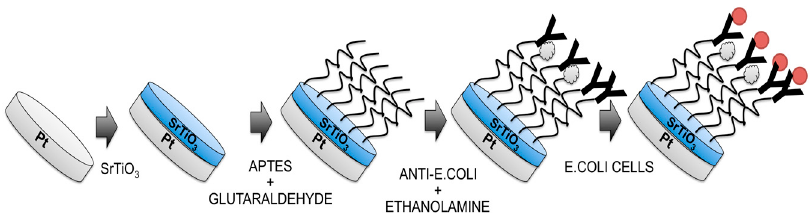
Figure 1. Steps used for the fabrication of Escherichia coli O157:H7 label-free immunosensor. At the end (right side) the measurement step is reported, too.